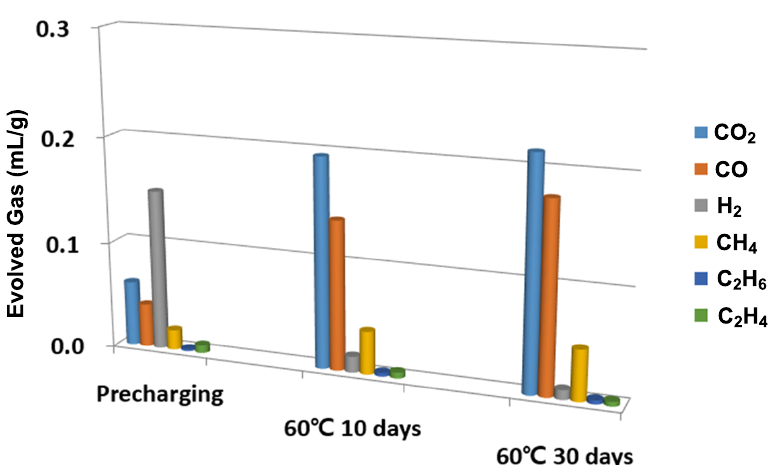
Figure 2. In order to show how the relative ratio of gaseous species changed over time, we showed the gas analysis results, particularly for the three cells that belong to three different stages. The pre-charging cell was charged up to 60% of capacity with a 0.2C rate and stored for one day at 25 ◦ C. For the other two cells, we stored them for 10 and 30 days after fully changing